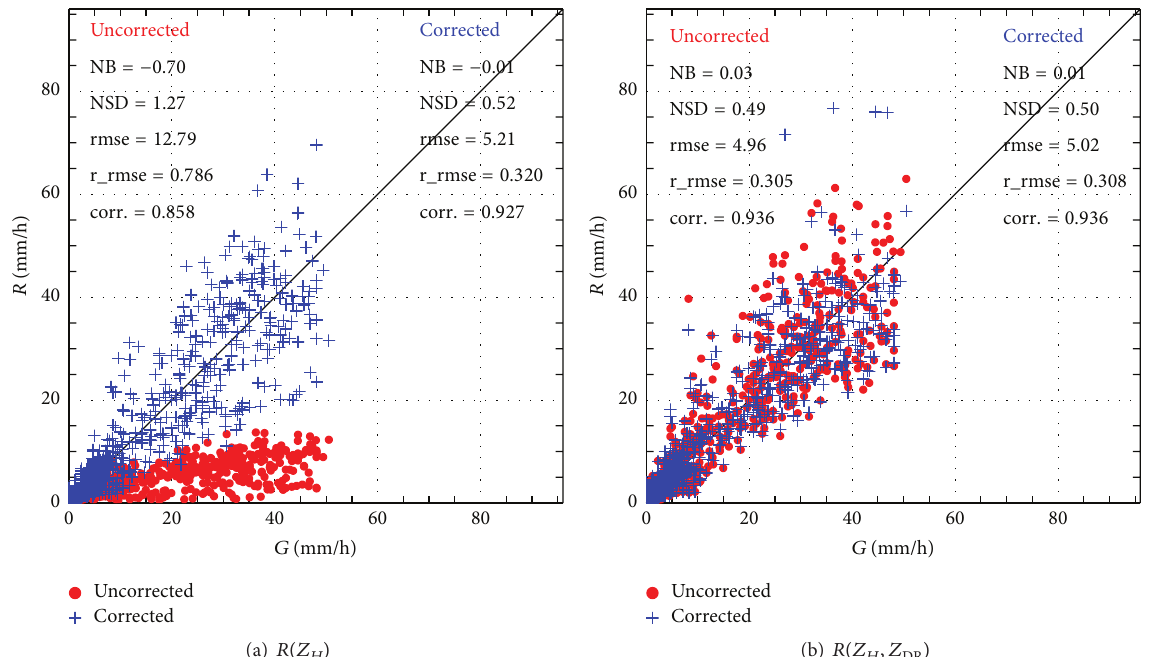
Figure 17: The scatter plots of 𝑅(0.38 km 2 ,10 min ) versus 𝐺(0.07 m 2 ,10 min ) (a) using 𝑍 𝐻 and (b) using 𝑍 𝐻 and 𝑍